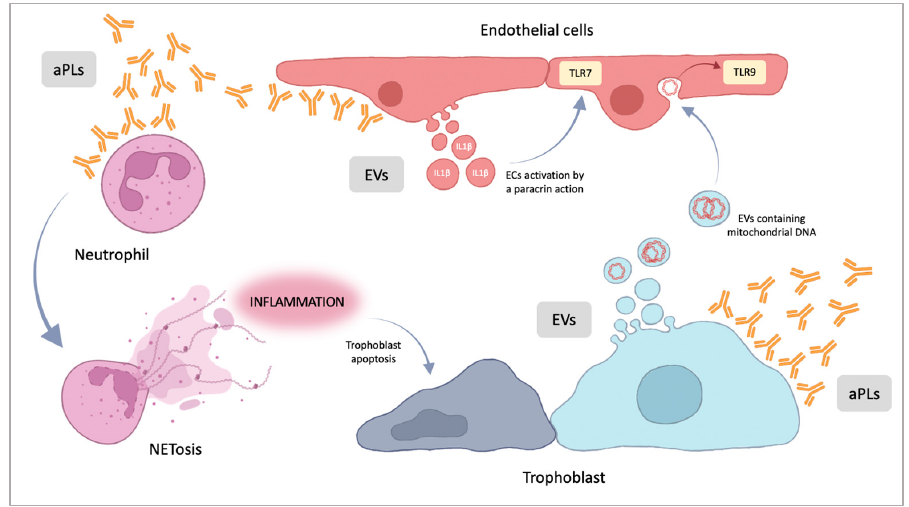
Figure 3. NETosis and extracellular vesicles in obstetrical APS pathogenesis. aPLs can lead to neutrophil NETosis promoting an inflammatory state in placental stroma that can induce trophoblast apoptosis. aPLs can promote endothelial cells (ECs) EVs generation, containing IL-1 β and ss-RNA that can activate, by a paracrine action, other ECs via TLR7. EV shedding is promoted also by aPLs in- teraction with trophoblast. Trophoblast EVs can contain several alarmins, such as mitochondrial DNA, that can activate endothelial cells via TLR9. aPLs = antiphospholipid antibodies. EVs =